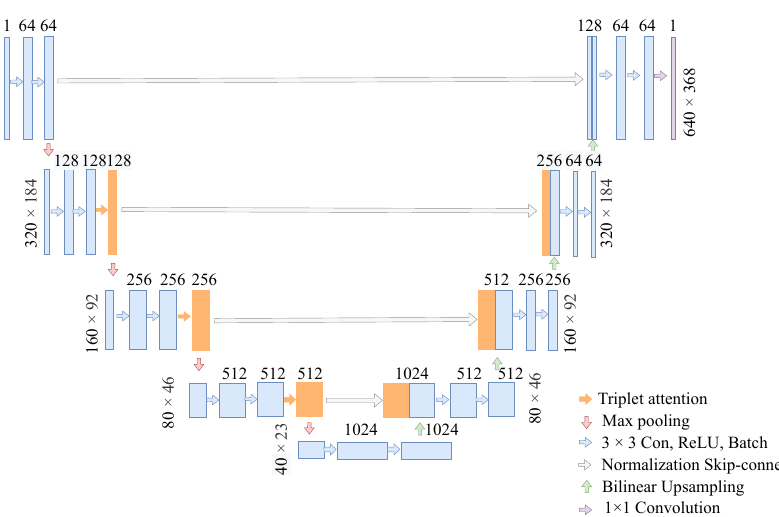
Figure 2. Illustration of the proposed TA-Unet. The model receives a sample size of 640 × 368 pixels as an input. Each blue arrow represents convolution operations with a 3 × 3 convolutional kernel followed by ReLU nonlinearity and batch normalization, the orange arrows represent triplet attention, and the red and green arrows stand for max-pooling and upsampling operations, respectively. The gray arrows connect the output of encoder layers with the input of corresponding decoder layers. The purple box in the decoder layer is the final segmentation map of the